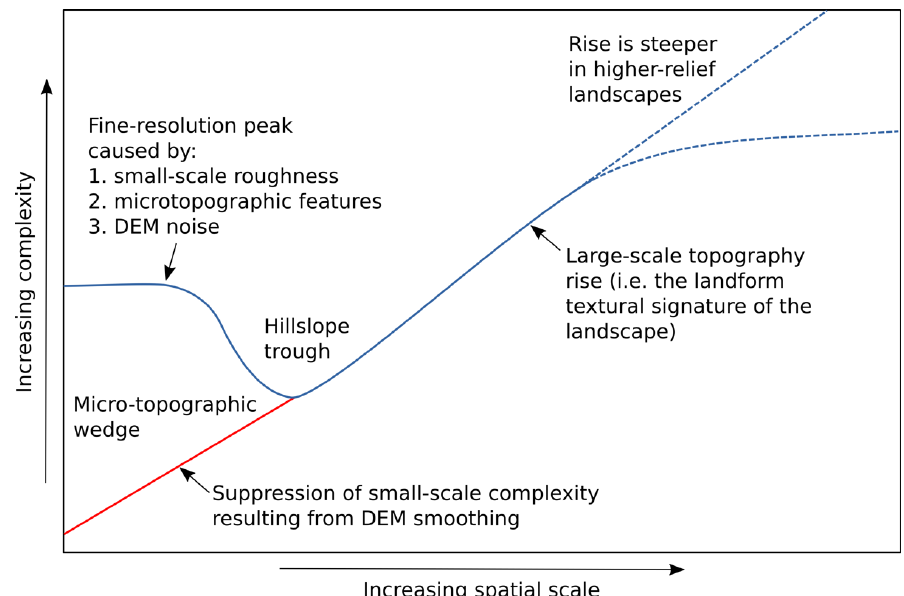
Figure 3. A conceptual model of the impact of an ideal DEM smoothing treatment on the CVA scale signature. The blue line represents the pattern of circular variance of aspect (CVA) for a hypothetical DEM and the red line indicates the effects of an ideal smoothing treatment. That is, smoothing should result in suppression of surface complexity at shorter scales while leaving larger scale complexity unaffected.